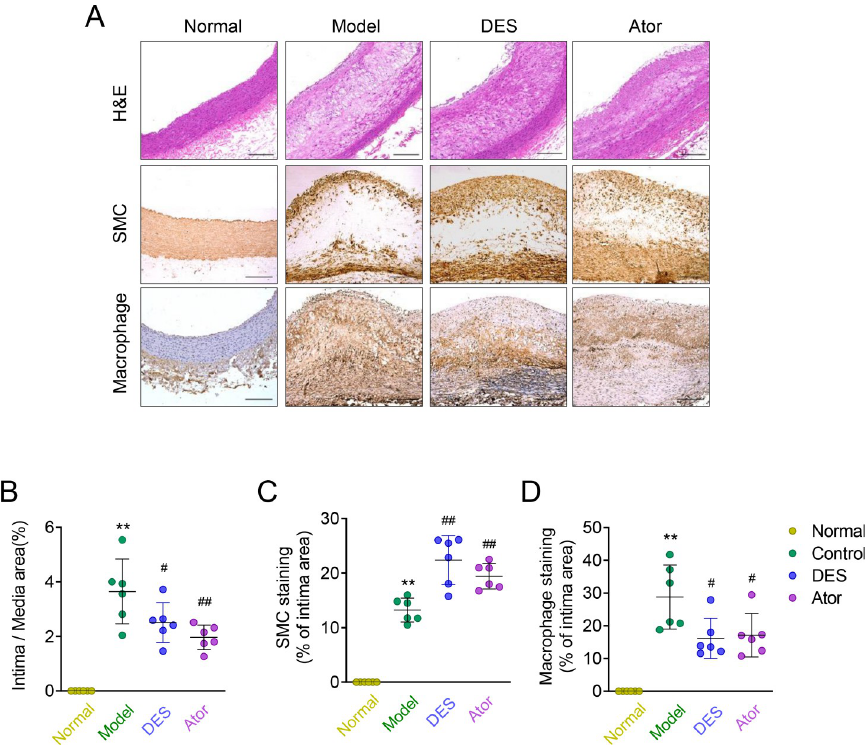
Fig 2. Desipramine and atorvastatin enhances atherosclerotic plaque stability. (A) Normal and atherosclerotic rabbits were treated with saline (Model), desipramine (DES), or atorvastatin (Ator), representative histological and Immunohistological staining of abdominal aortic plaque components including alpha smooth muscle actin ( α -SMA) staining of SMCs, and RAM-11 staining of macrophages. Scale bar = 250 μ m; (B) The ratio of intima/media area in each rabbit was analyzed; (C, D) Quantitative analysis of SMCs and macrophages in 4 groups. Data are expressed as Mean ± SD, n = 6; � , �� represent P < 0.05, P < 0.01 in comparison with Normal; #, ## represent P < 0.05, P < 0.01 in comparison with